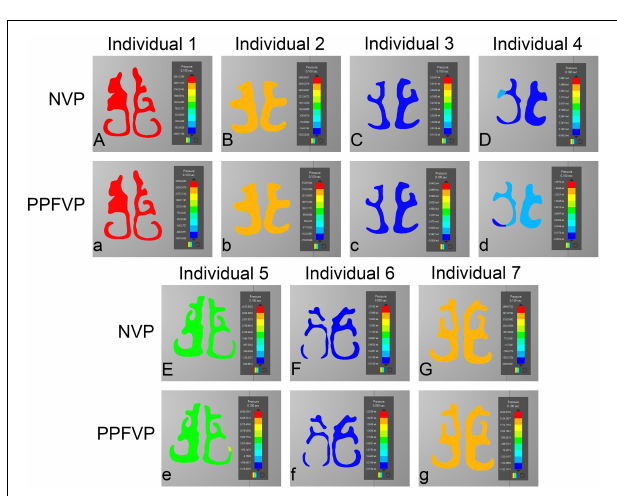
FIGURE 4 | Airflow pressure patterns through the turbinates. The airflow pressure patterns through the turbinates of seven individuals were demonstrated. NVP, normal velopharyngeal closure (one port); PPFVP, velopharyngeal closure after posterior pharyngeal flap palatoplasty (two ports). The scale bar cannot be fixed because of the real-time simulation process in which the scale bar was changing with time.